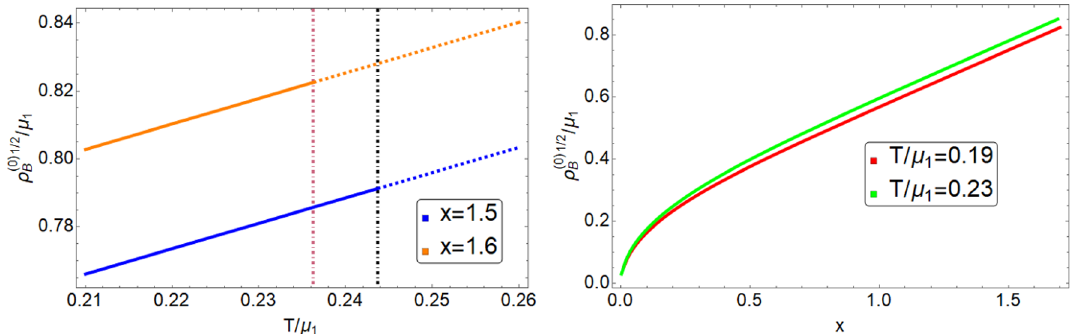
Figure 4 . The charge density ρ (0) as the function of temperature T (left) and doping parameter B x(right). The solid lines in color stand for ρ (0) in black hole with CDW, while the dashed lines in B color stand for ρ (0) in RN black hole. The vertical lines denote the location of CDW phase transition. B